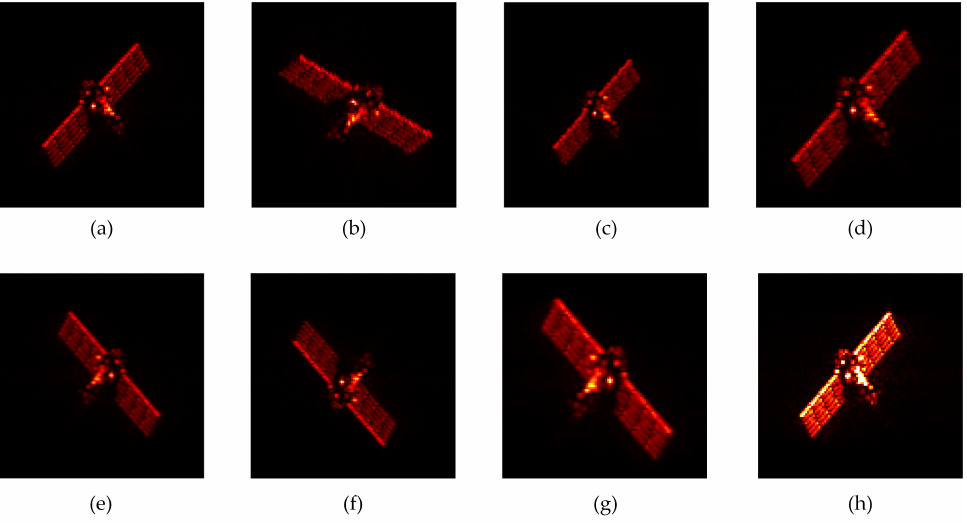
Figure 9. Illustrations of the data augmentation operators. ( a ) Original, ( b ) rotated, ( c ) scaled down, ( d ) scaled up, ( e ) horizontal flip, ( f ) vertical flip, ( g ) center crop, resize, and horizontal flip, and ( h ) normalized ISAR